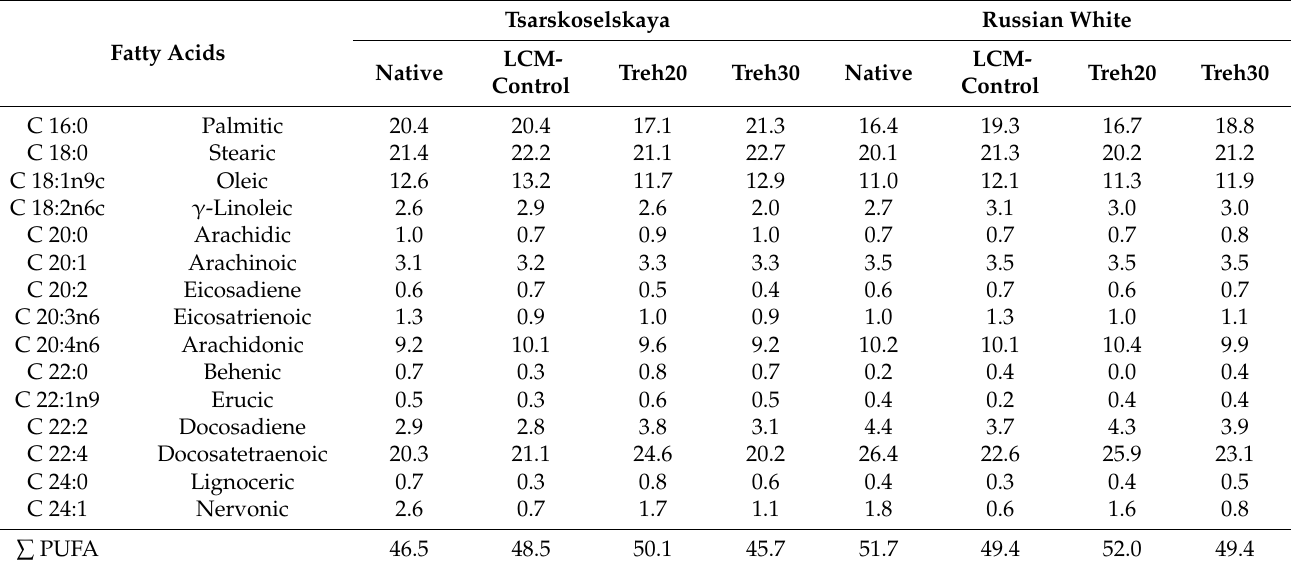
Table 3. Fatty acid composition of plasma membrane lipids of rooster spermatozoa of native and frozen/thawed semen depending on the composition of the cryoprotective